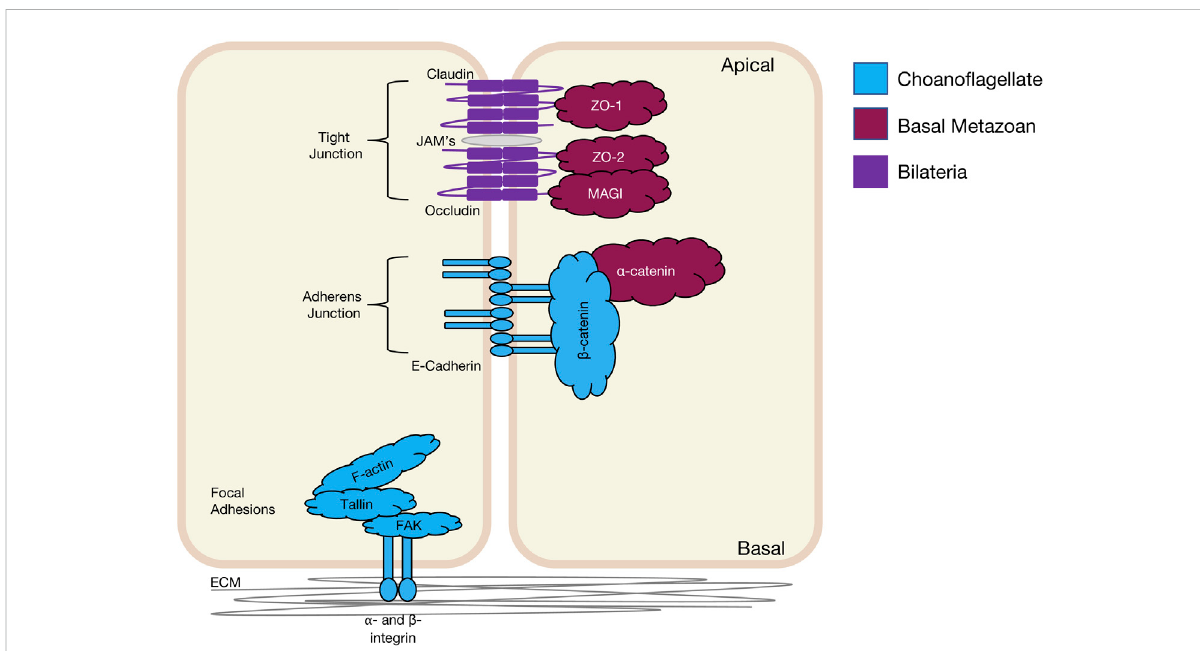
FIGURE 4 Bilaterian representation of epithelial cell-cell and cell-ECM junctions and their emergence in evolution. It should be noted that for Claudin, whilst represented as a basal metazoan innovation, it has only been identi fi ed in Cnidaria. There are Occludin-like genes present in basal metazoans but it is not known if they have the same functional properties as in